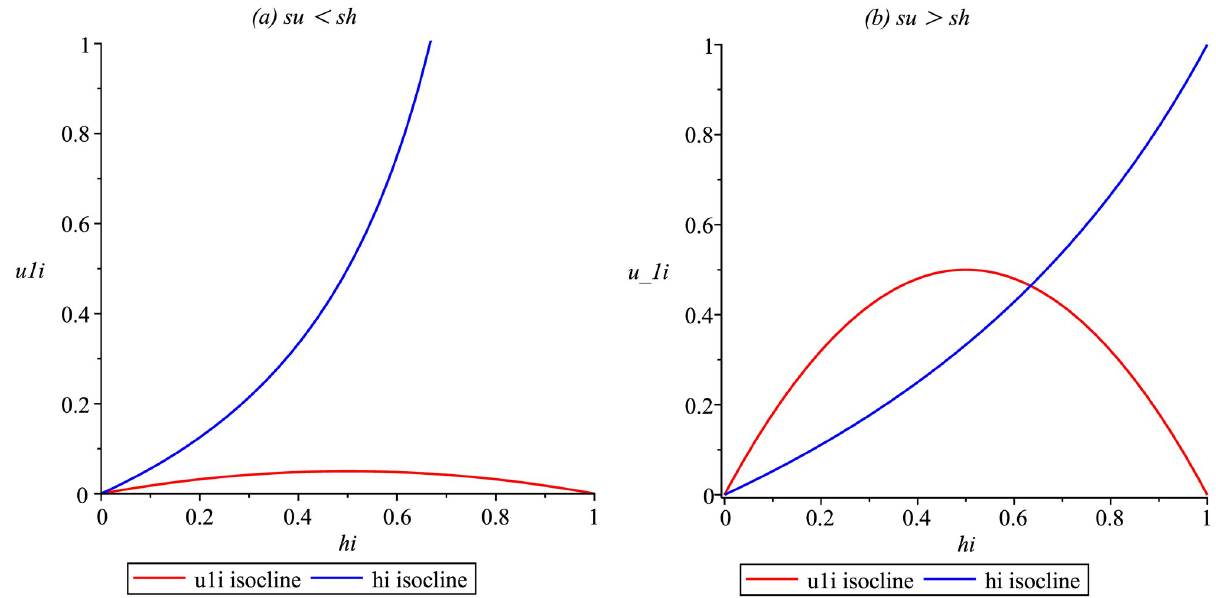
below the slope of h isocline (a) and initial slope of u 1 I I